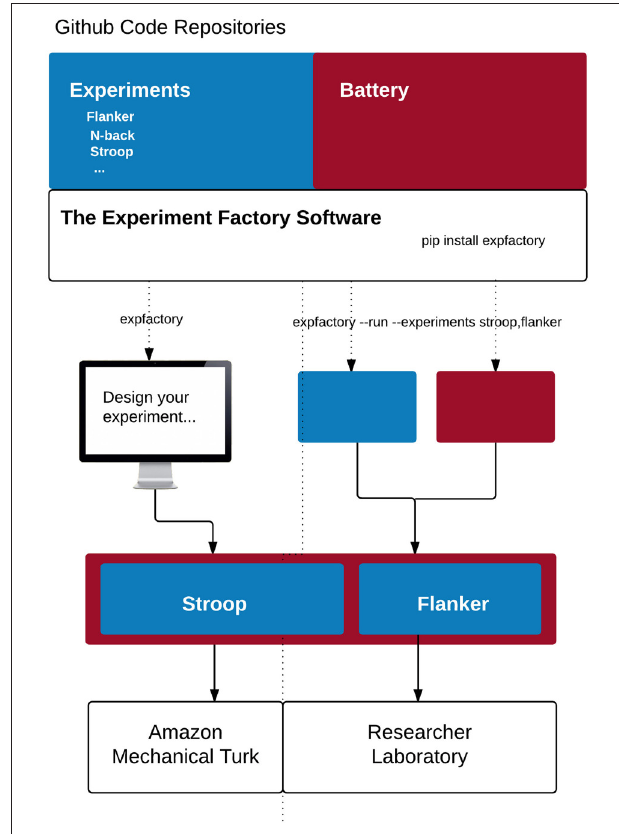
FIGURE 1 | The experiment factory core: Experiments, a battery skeleton, and the software are openly available on Github. Installation of the Experiment Factory tool allows a researcher to run a sequence of experiments on the fly (right) or to generate a local folder or virtual machine to deploy experiments to Amazon Mechanical Turk using Psiturk (left)